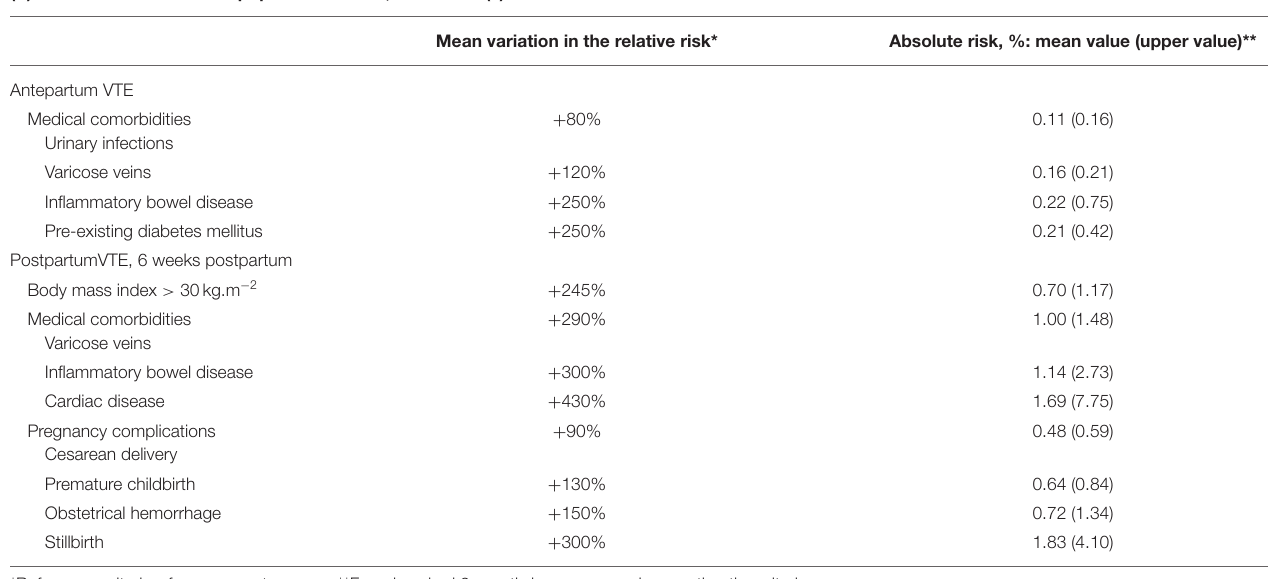
TABLE 1 | Risk factors (RFs) for venous thromboembolism (VTE) around pregnancy. (A) RFs identified in the UK population cohort, 1995-2009 (7)